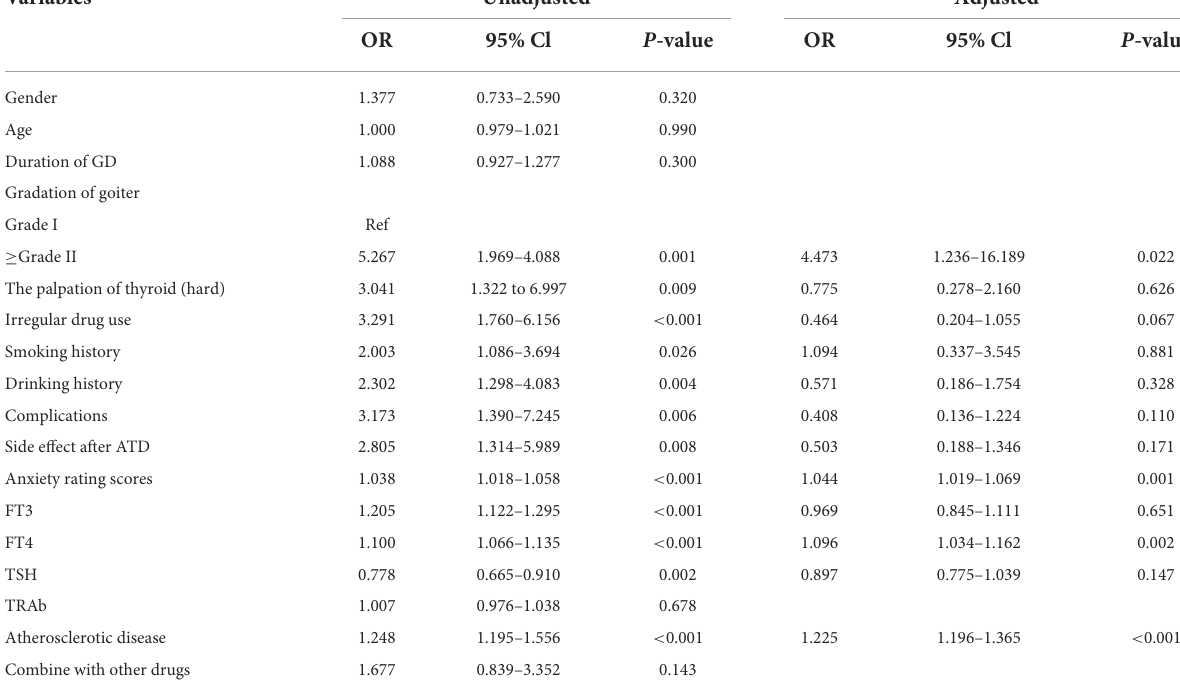
TABLE 4 Logistic analysis of risk factors.